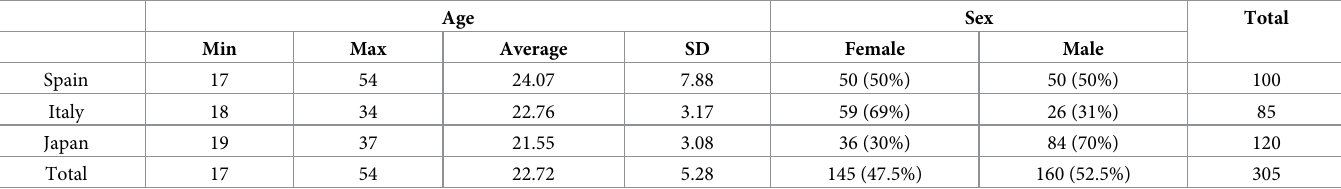
Table 1. Descriptive statistics of the participant